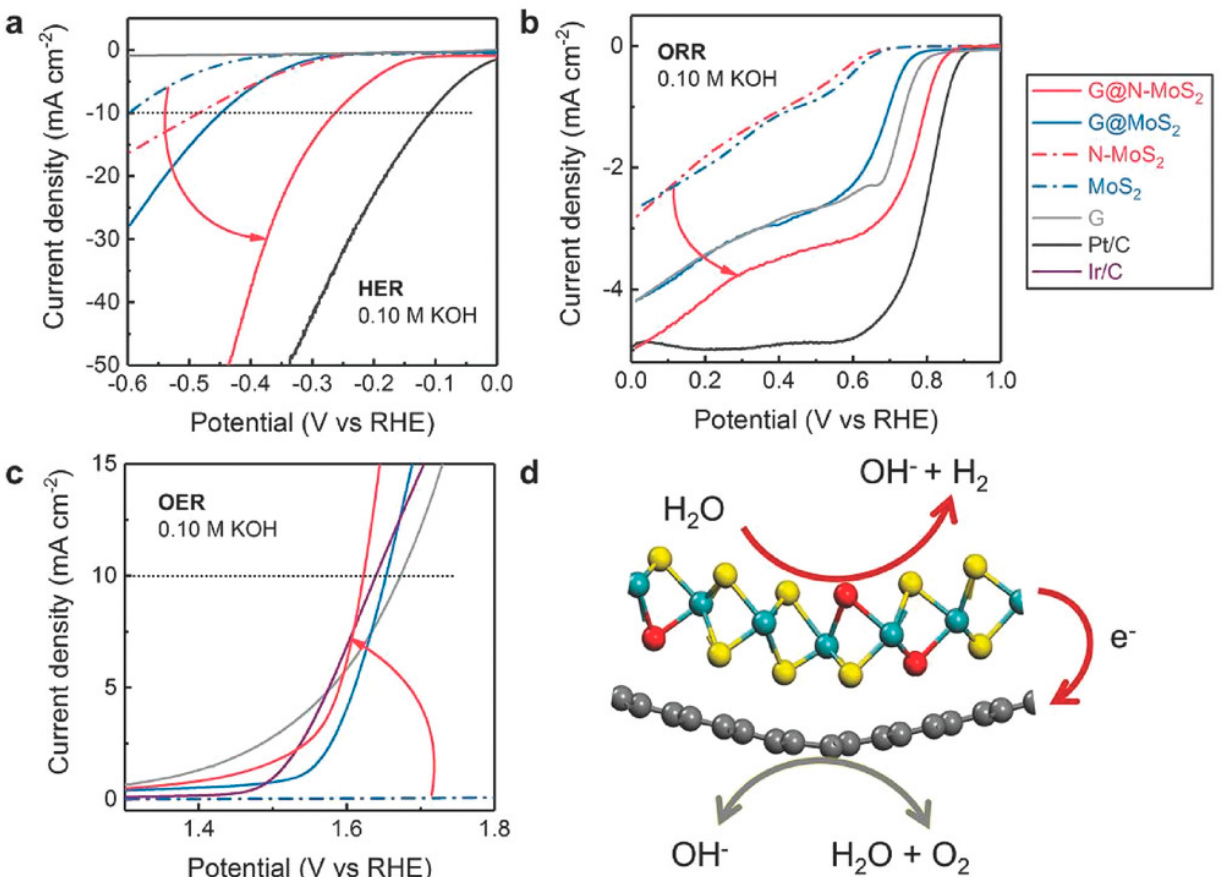
Figure 5. ( a ) HER polarization curves obtained in N 2 -saturated 0.10 M KOH; ( b ) ORR, and ( c ) OER polarization curves in O 2 -saturated 0.10 M KOH solution; ( d ) the electron transfer effects in G@N-MoS 2 heterostructures for ORR, OER, and HER. Reprinted (adapted) from [41] with permission from John Wiley and sons.